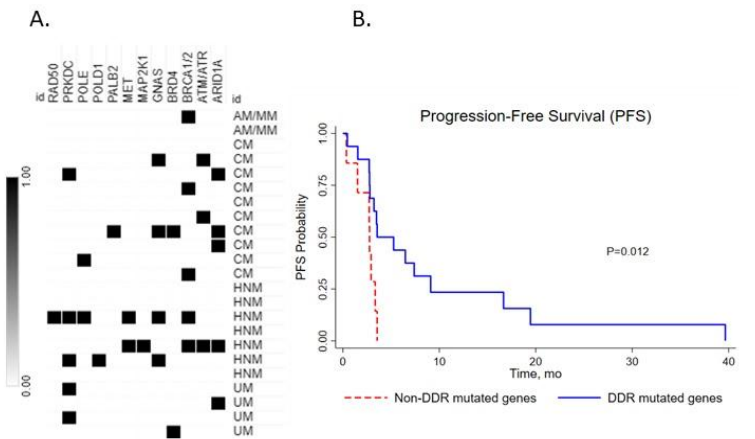
Figure 3. ( A ) Map of metastatic melanoma subtypes with DDR gene mutations. ( B ) Kaplan–Meier plots of progression-free survival (PFS) for cohorts with DDR mutated genes and without DDR mutated genes with log-rank p -value.